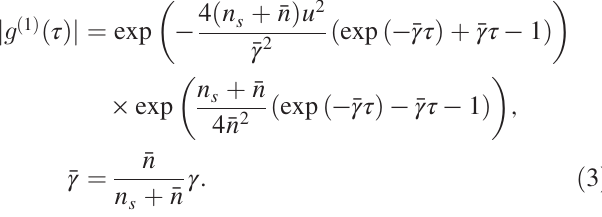
FIG. 5. First-order coherence properties of the single-mode polariton laser. (a) A spatial interference image of the polariton laser at zero time delay. (b) The interference fringe along x axis obtained from (a) by integration along the y axis. The dots are data, and the solid line is a fit by Eq, (A1) with g ð 1 Þ ð 0 Þ ¼ 0 . 94 (see the Appendix). (c,d) The measured g ð 1 Þ ð τ Þ vs τ (dots), exponential fits (red solid lines), and Gaussian fits (black dashed lines), for ¯ n ¼ 2 . 66 and 968, respectively. (e) The phase coherence time τ The dots are taken from the measured g ð 1 Þ ð τ Þ for each value of ¯ n . The line is calculated from Eq. (3) using the fitted parameters. Inset: Comparison between the interaction energy U (dots) and decay rate γ (yellow-shaded region) of the condensate vs ¯ n . The error bars and thickness of the shaded area are determined by fitting errors with a 95% confidence interval. The rectangle and diamond marks represent ¯ n ¼ 2 . 66 and ¯ n ¼ 968 ,